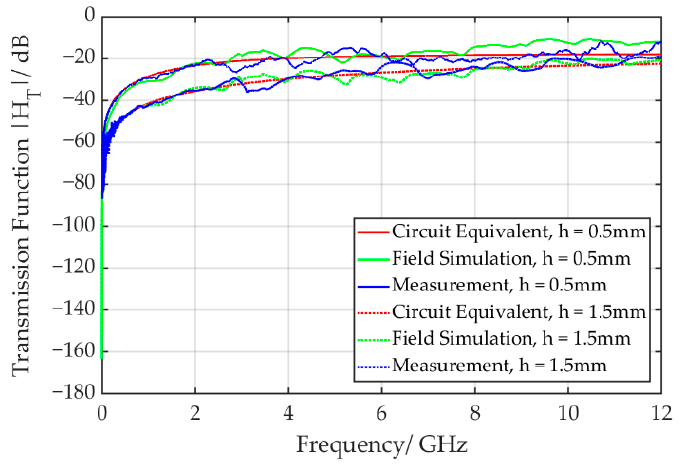
Figure 4. Comparison of ( ) H f from circuit simulation, field simulation, and measurement.